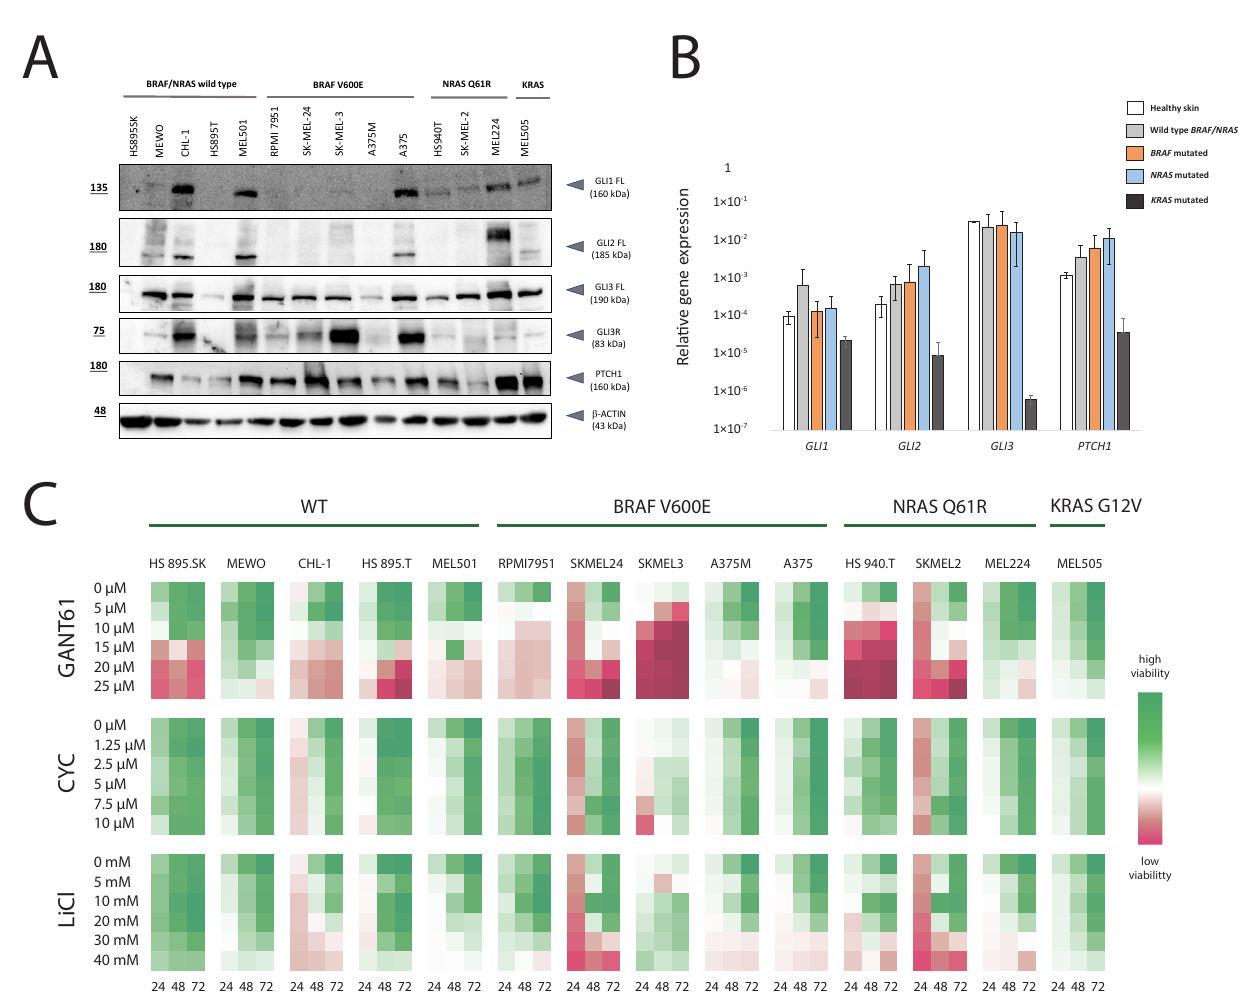
Figure 1. HH-GLI pathway activity in melanoma cell lines. ( A ) Western blot analysis of relative protein expression levels of GLI1, GLI2, GLI3 and PTCH1 in a panel of 14 melanoma cell lines. FL refers to the full-length protein, while R refers to the repressor form. ( B ) Average gene expression of GLI1 , GLI2 , GLI3 and PTCH1 relative to the housekeeping gene RPLP0 summarized according to the mutational background of the tested panel of melanoma cell lines. ( C ) Heatmap showing MTT proliferation assay on 14 melanoma cell lines. Cells were treated with three different HH-GLI pathway inhibitors in five doses, during 24, 48 and 72 h. Green color indicates high cell viability and red color indicates low viability (cell death). The uncropped blots are shown in File